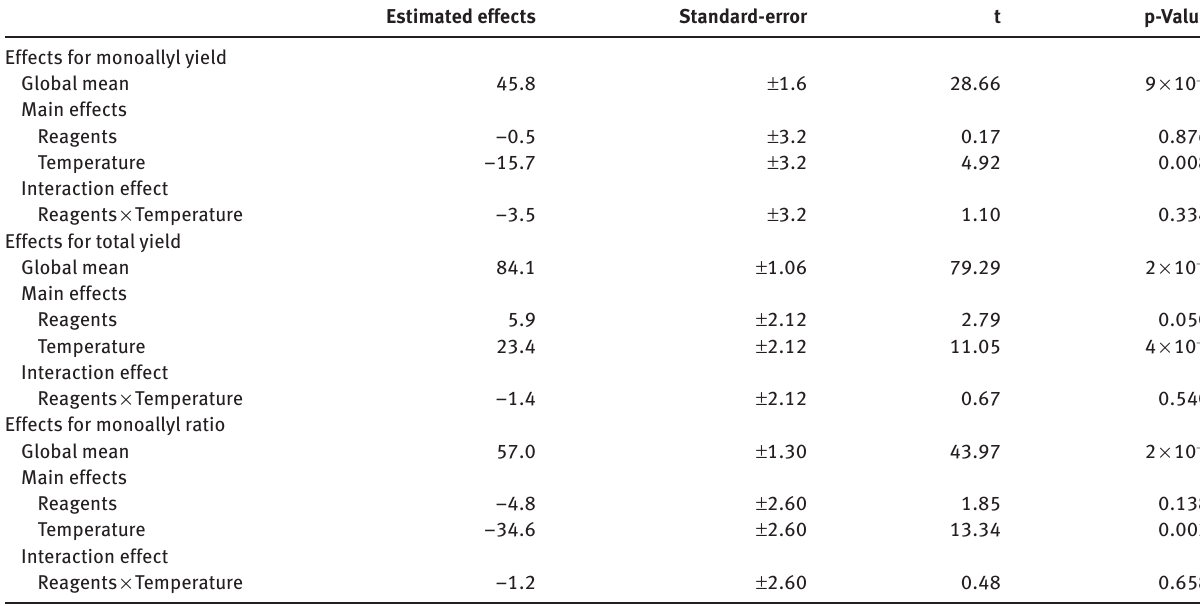
Table 3: Calculated effects for each factor in the background experiments.